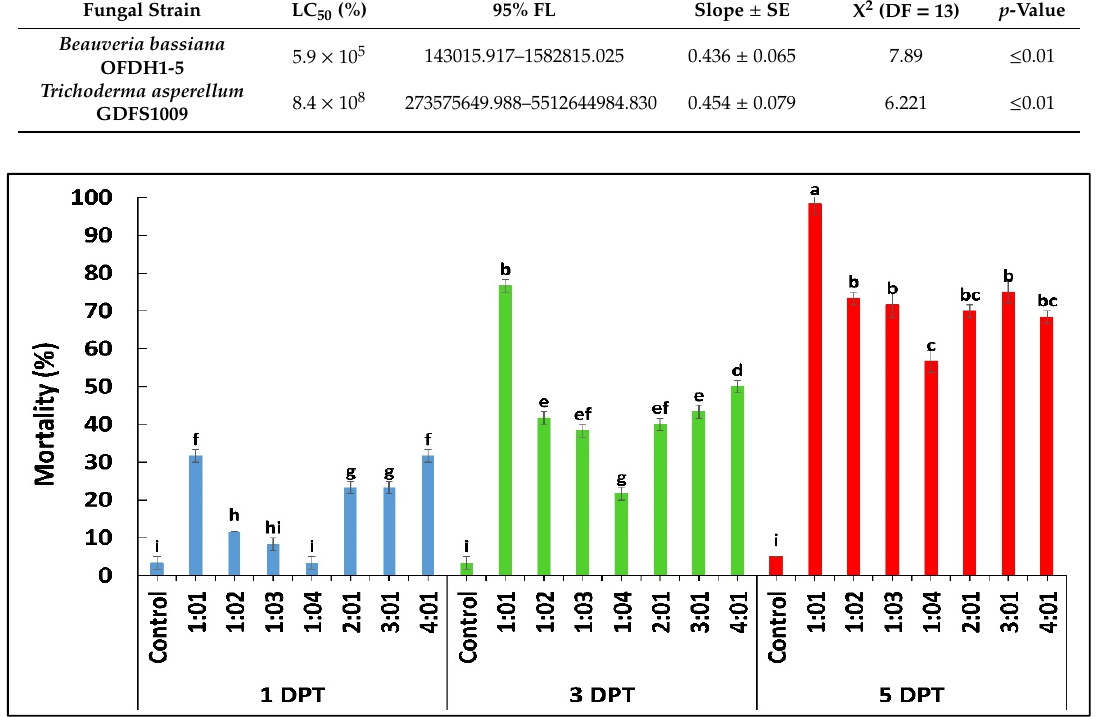
Table 1. Median lethal concentration (LC 50 ) value of B. bassiana OFDH1-5 and T. asperellum GDFS1009 bioassayed against O. furnacalis .